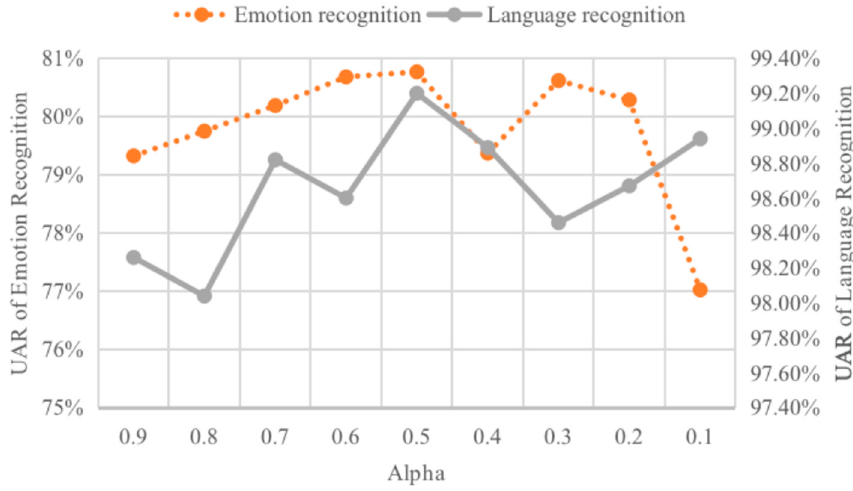
Figure 3. The performance of two tasks in the E_MSFL with different alpha